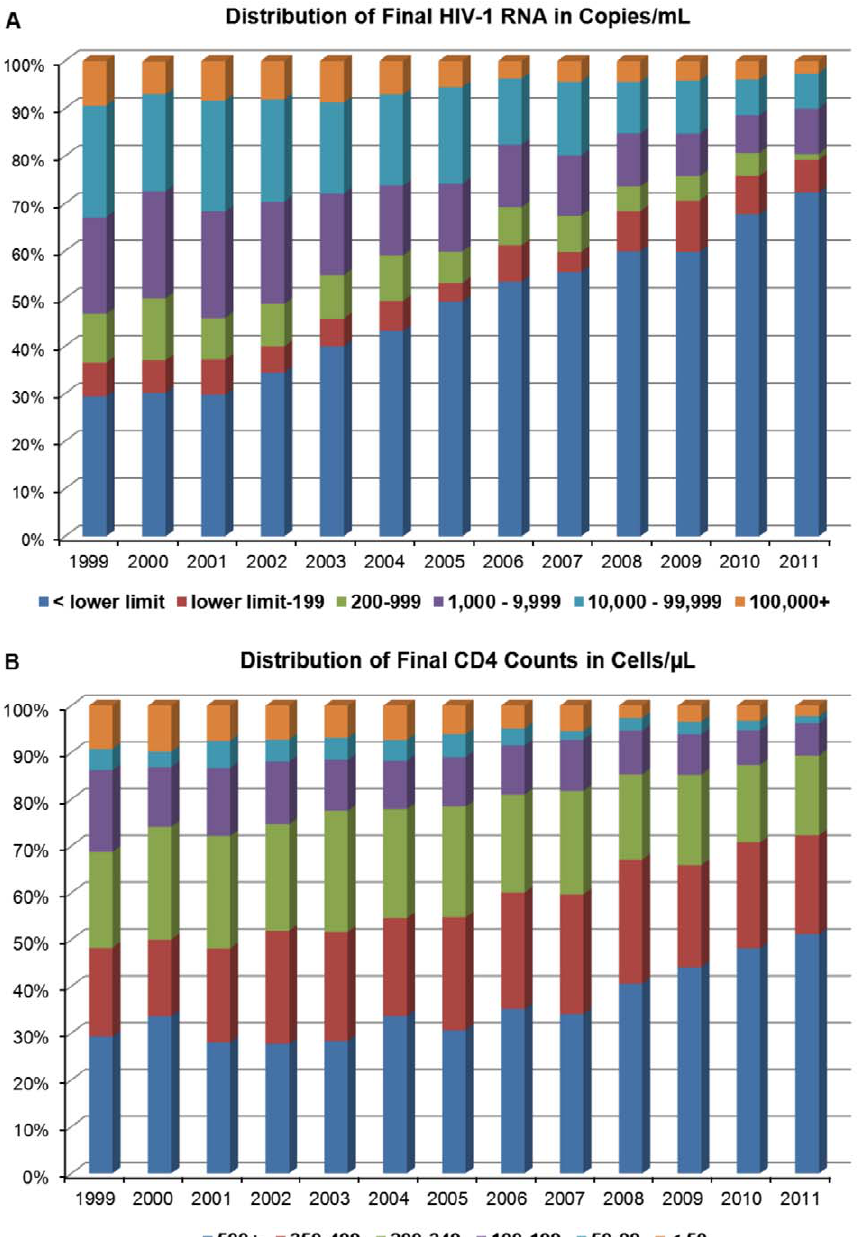
Figure 1. Distribution of final HIV-1 RNA and CD4 cell counts. ( A ) Final HIV-1 RNA and ( B ) final CD4 cell counts by calendar year for 1,814 unique patients tested for both parameters at least once from 1999 through 2011. The number of individuals each year ranged from 575 in 1999 to 854 in 2011. The HIV-1 RNA lower limit of quantitation was 50 copies/mL from 1-1-99 to 10-17-02, 75 copies/mL from 10-18-02 to 3-4-08 and 40 copies/mL from 3-5-08 to